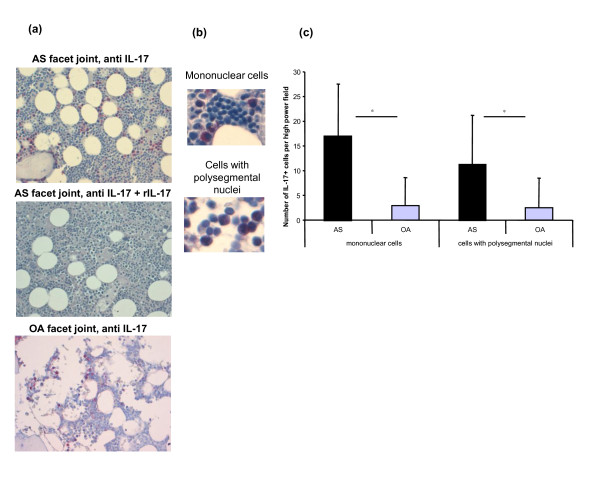
In situ analysis and quantification of IL-17+ cells in patients with ankylosing spondylitis or osteoarthritis. (a) In situ analysis of IL-17+ cells in facet joints of ankylosing spondylitis (AS) (top) and osteoarthritis (OA) (bottom) patients. The specificity of IL-17 staining (top) is shown by blocking the anti-IL-17 antibody with recombinant IL-17 (rIL-17) (middle). (b) and (c) The frequency of IL-17-secreting mononuclear cells and cells with polysegmental nuclei in the bone marrow of AS facet joints was significantly higher in AS than in OA facet joints. *P < 0.001.